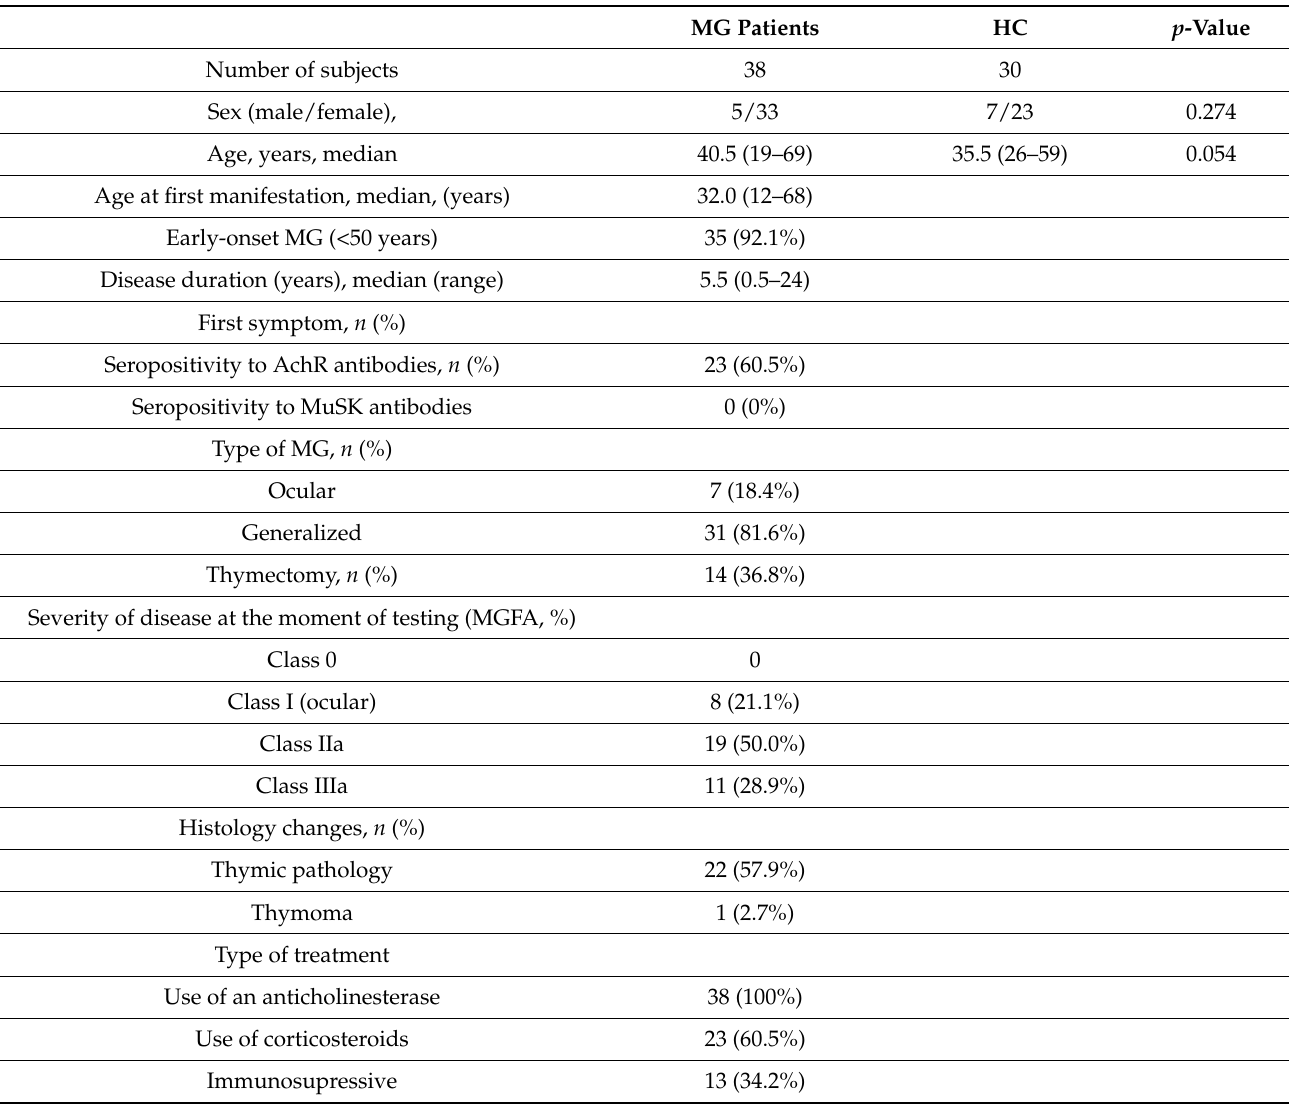
Table 1. Clinical and demographic baseline characteristics of patients. MG